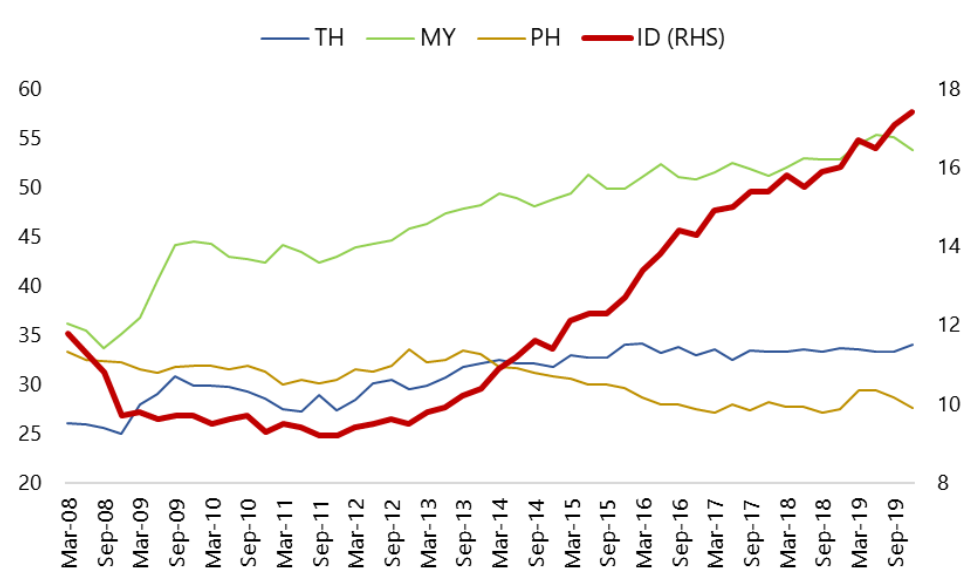
Figure 1. The GB as a percentage of GDP (2008–2019)